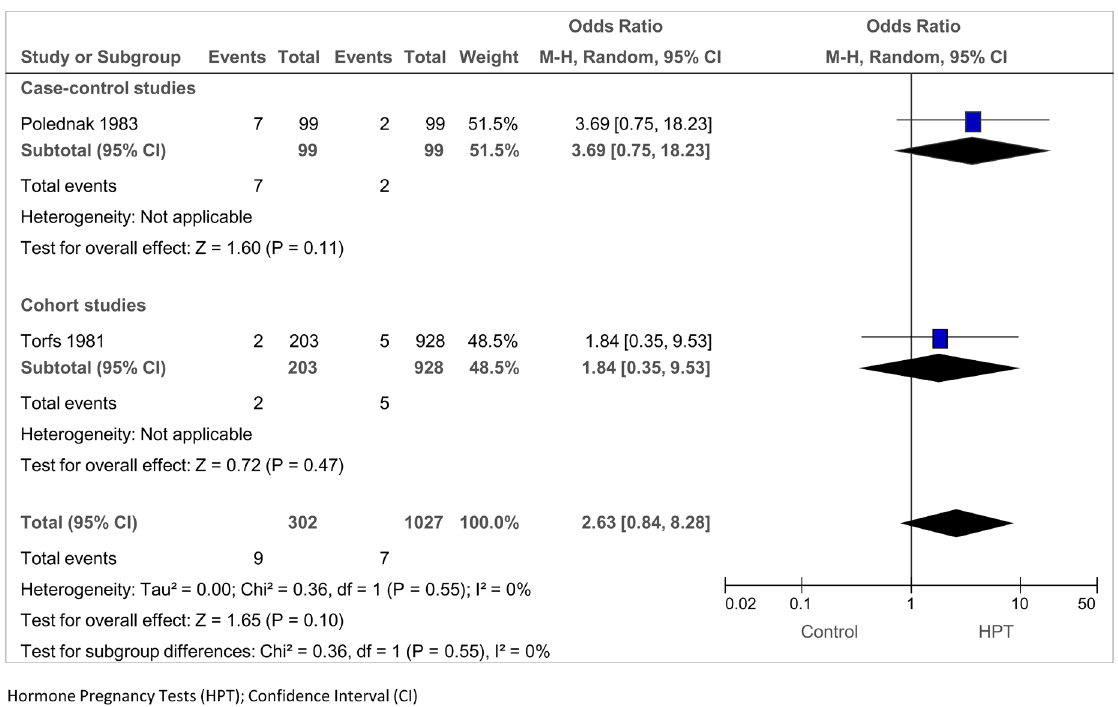
Figure 6. Association of exposure to oral hormone pregnancy tests (HPTs) in pregnancy and urogenital malformations in the offspring.